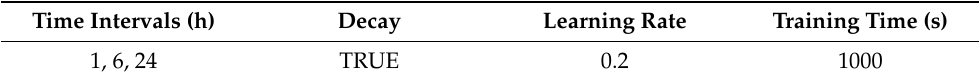
Table 7. The parameter settings of the proposed MLPNN. Time Intervals